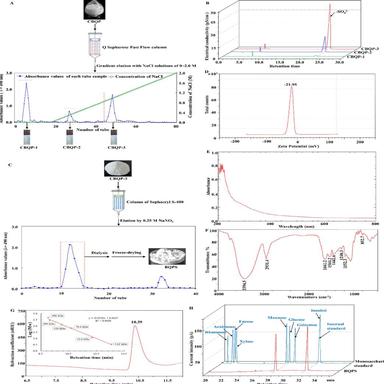
The elution curve of CBQP by Q Sepharose Fast Flow column chromatography separation (A). the ion chromatogram of CBQP-1, CBQP-2 and CBQP-3 (B). the elution curve of CBQP-3 by Sephacryl S-400 column chromatography separation (C). Zeta potential analysis (D), UV–visible spectrum (E), FT-IR spectrum (F), HPGPC of molecular weight determination (G) and GC for monosaccharide composition analysis (H) of BQPS.